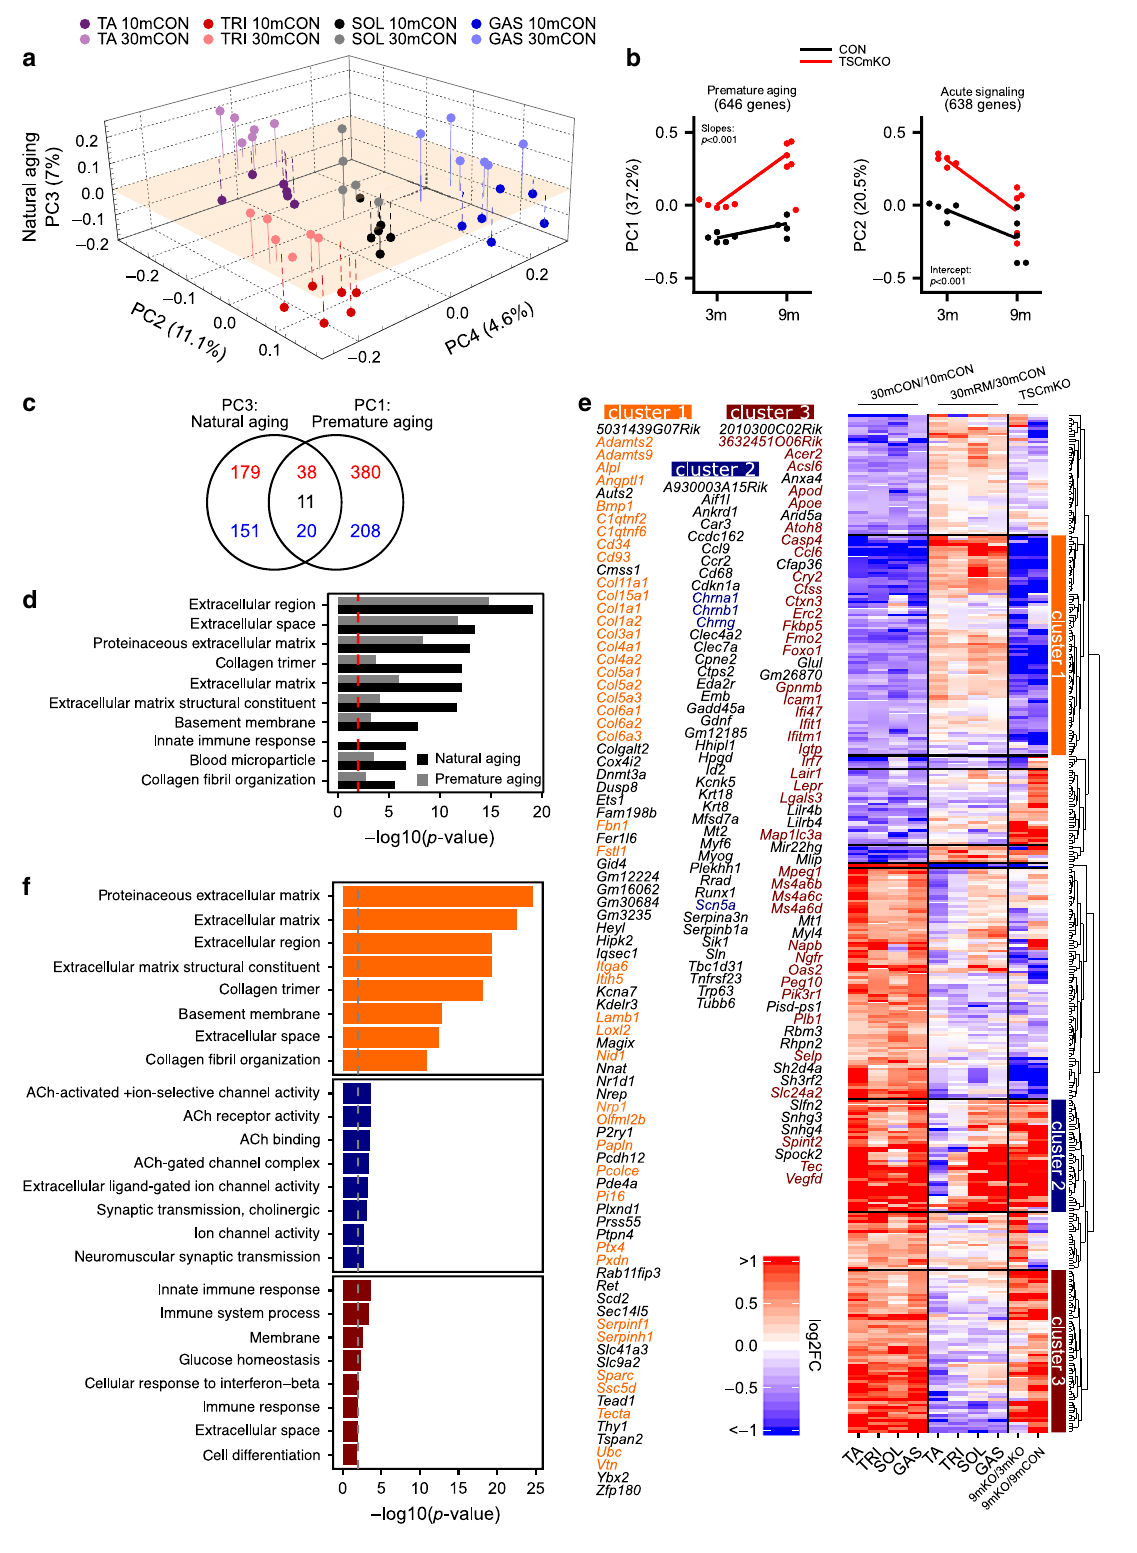
NMJ (Fig. 7d). On the other hand, the age-related depletion of genes associated with cluster 1 was more prominent in NMJ than non-NMJ regions, and may particularly compromise the stability of the NMJ and its ability to remodel following com- mon age-related remodeling events, such as muscle fi ber degeneration/regeneration and motor unit loss 42